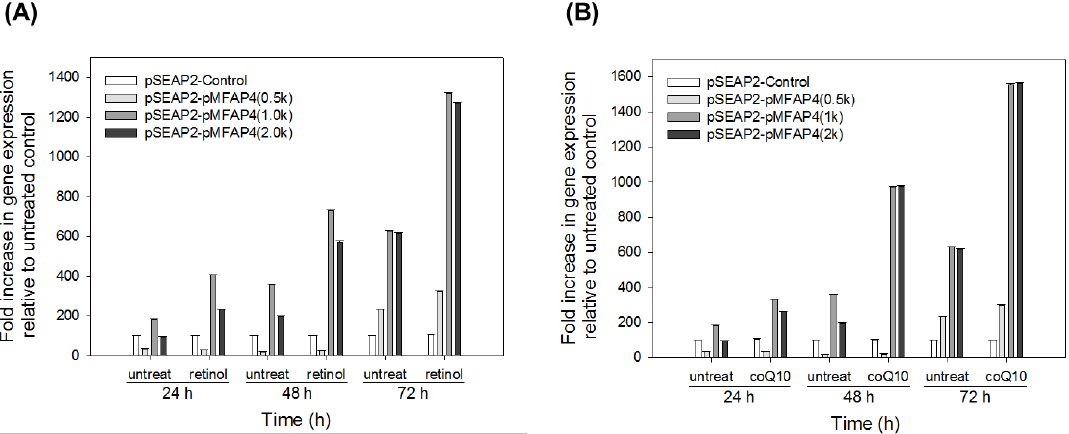
Figure 7. Effect of ( A ) retinol and ( B ) coQ10 on the expression of the human MFAP4 promoter in Detroit 551 cells. Data are presented as means ± SE.